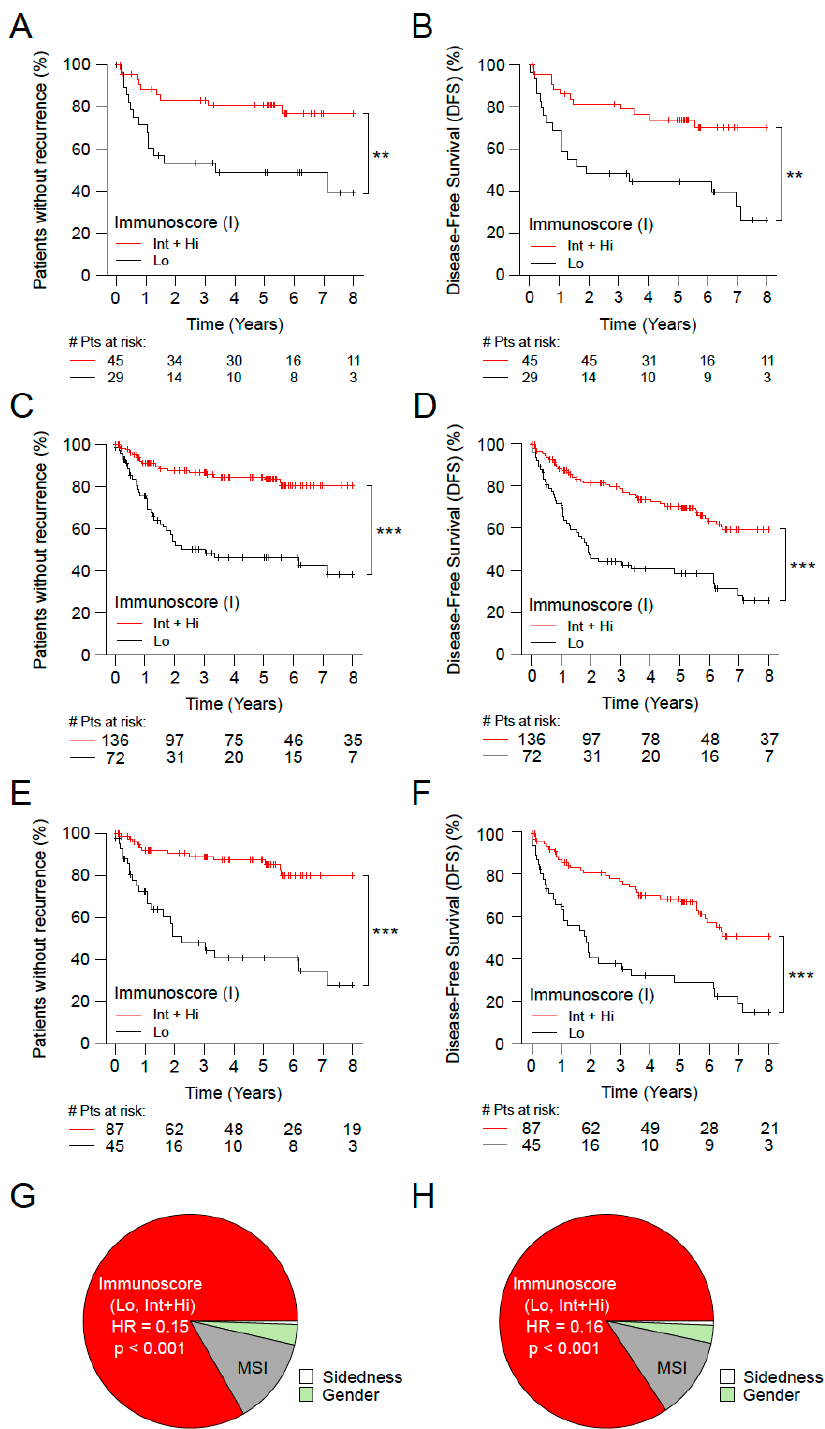
Figure 3. The impact of Immunoscore on very high-risk patients with Stage II colon cancer. Kaplan- Meier curves of Immunoscore (I) two categories: Lo (0–25%, black) and Int+Hi (>25–100%, red) are shown for TTR ( A,C,E ) and DFS ( B,D,F ) for subgroups of Stage II patients from cohorts 1 and 2 with very high risk (T4 primary tumors and VELIPI+) ( A,B ), T4N0 patients ( C,D ), and T4N0 patients who did not received chemotherapy ( E,F ). Relative importance of each risk parameter to survival risk for TTR ( G ) and DFS ( H ) using the χ 2 proportion test for clinical parameters and Immunoscore corresponding to panels C and D. Significant logrank p -values are marked as *** p < 0.001, ** 0.001 < p ≤ 0.01.